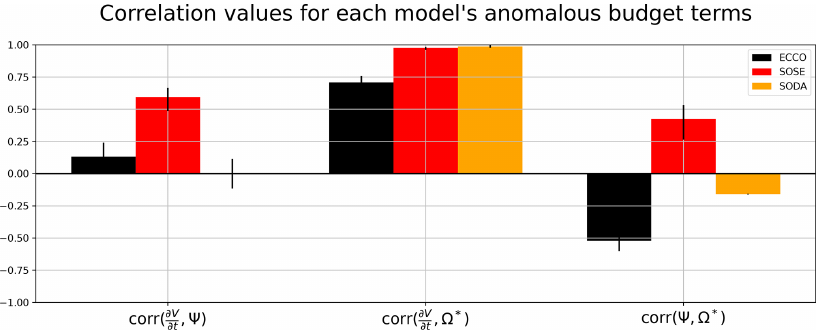
Figure 12. Correlation (and associated error bars) between the main budget terms from each model. The bars in black represent the correlation values in ECCO, red bars those in SOSE and orange bars those in